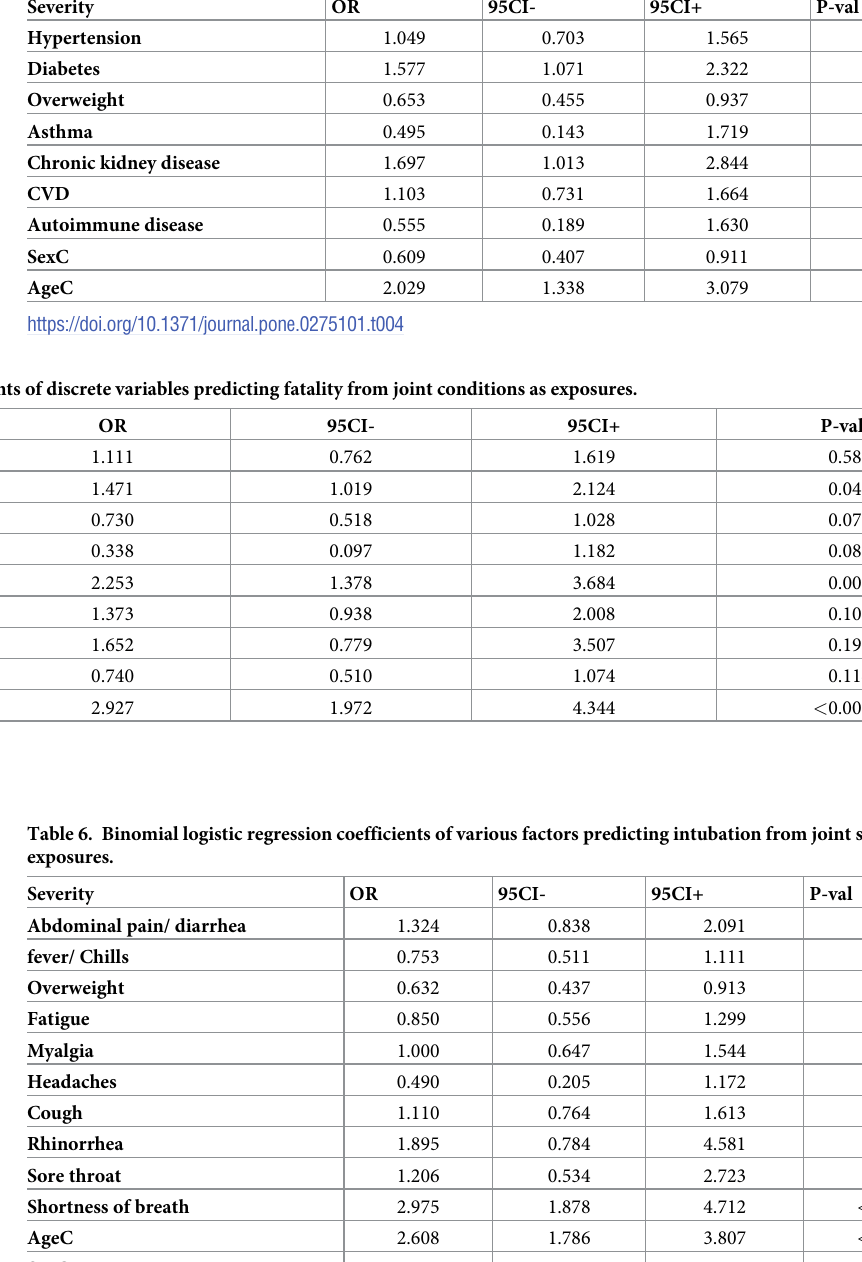
Table 4. Binomial logistic regression odds ratios of discrete variables predicting intubation from joint conditions as exposures.